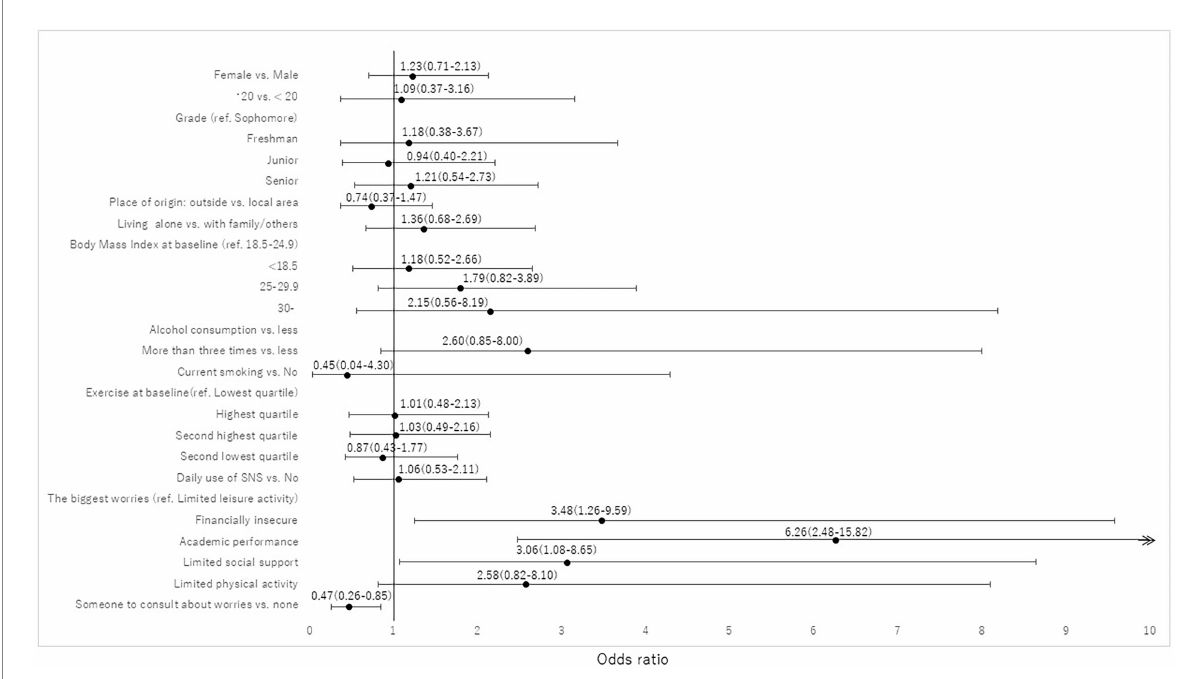
FIGURE 3 Risk and coping factors associated with new onset of suicide related ideation at T 2. The multivariate logistic model demonstrated that financial insecurity (OR, 3.48, 95% CI, 1.26–9.59), academic performance (OR 6.26, 95% CI, 2.48–15.82), and limited social support (OR 3.06, 95% CI, 1.08– 8.65) were significantly associated with a new onset of suicidal-related ideation, while having someone to consult with about worries (OR 0.47, 95% CI, 0.26–0.85) was a coping